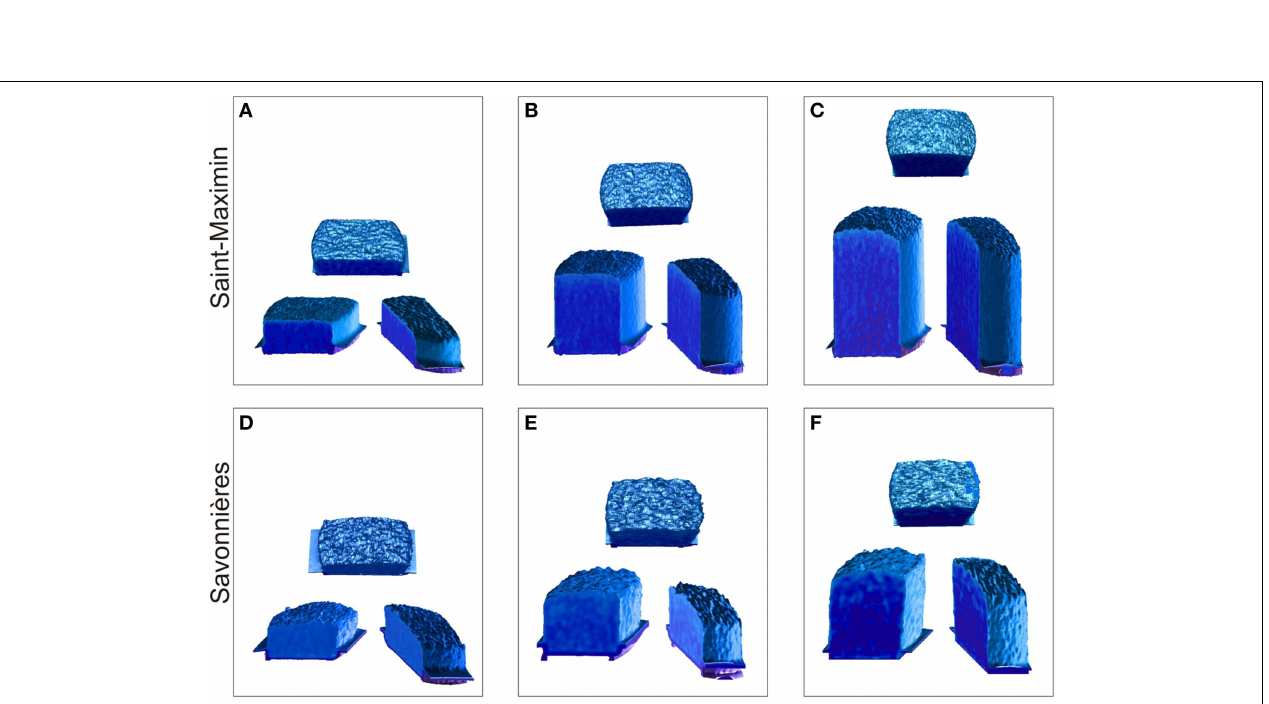
FIGURE 11 | 3D side and top views of the region invaded by water at different times during imbibition in the Saint-Maximin (A–C) and the Savonnières (D–F) samples.